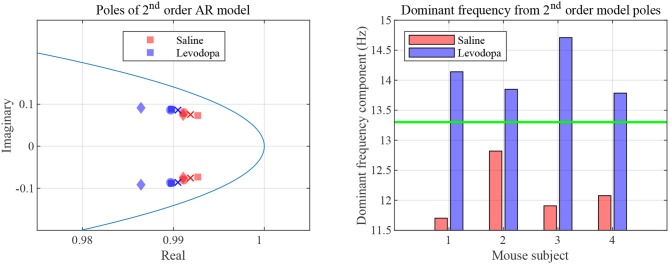
Second order LPC model with dopamine-depleted mice (mice 1–4). Left: second order poles for striatal LFPs in dopamine-depleted mice. Shown are the complex conjugate pairs p1 and p2, for data sets for dopamine-depleted mice following treatment with saline (red) or levodopa (blue). The unit circle line is shown in light blue. The X and Y axes represent the real and imaginary, respectively, parts of the poles. Each symbol represents a single pole from a single epoch. Squares represent data from mouse 1, circles from mouse 2, diamonds from mouse 3, and crosses from mouse 4. Right: dominant frequency components obtained from the second order poles. The threshold (green) is obtained by averaging the maximum frequency for saline and minimum frequency for levodopa session.